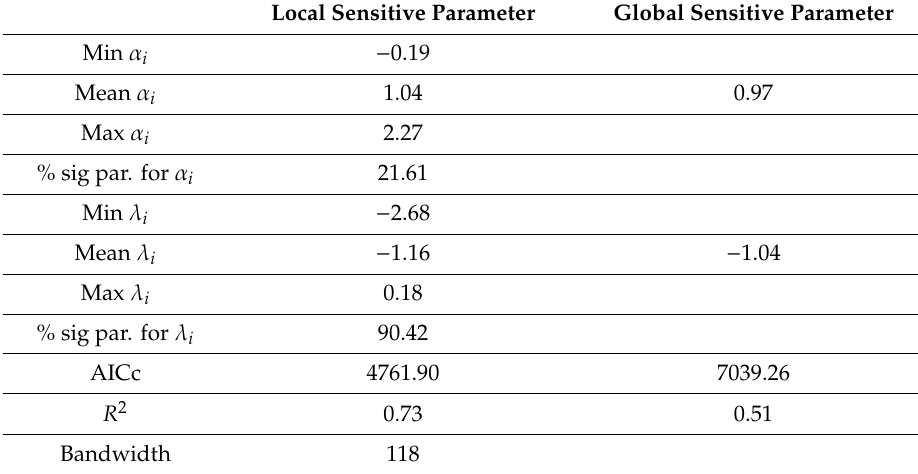
Table 3. Evaluation results of global and local sensitive